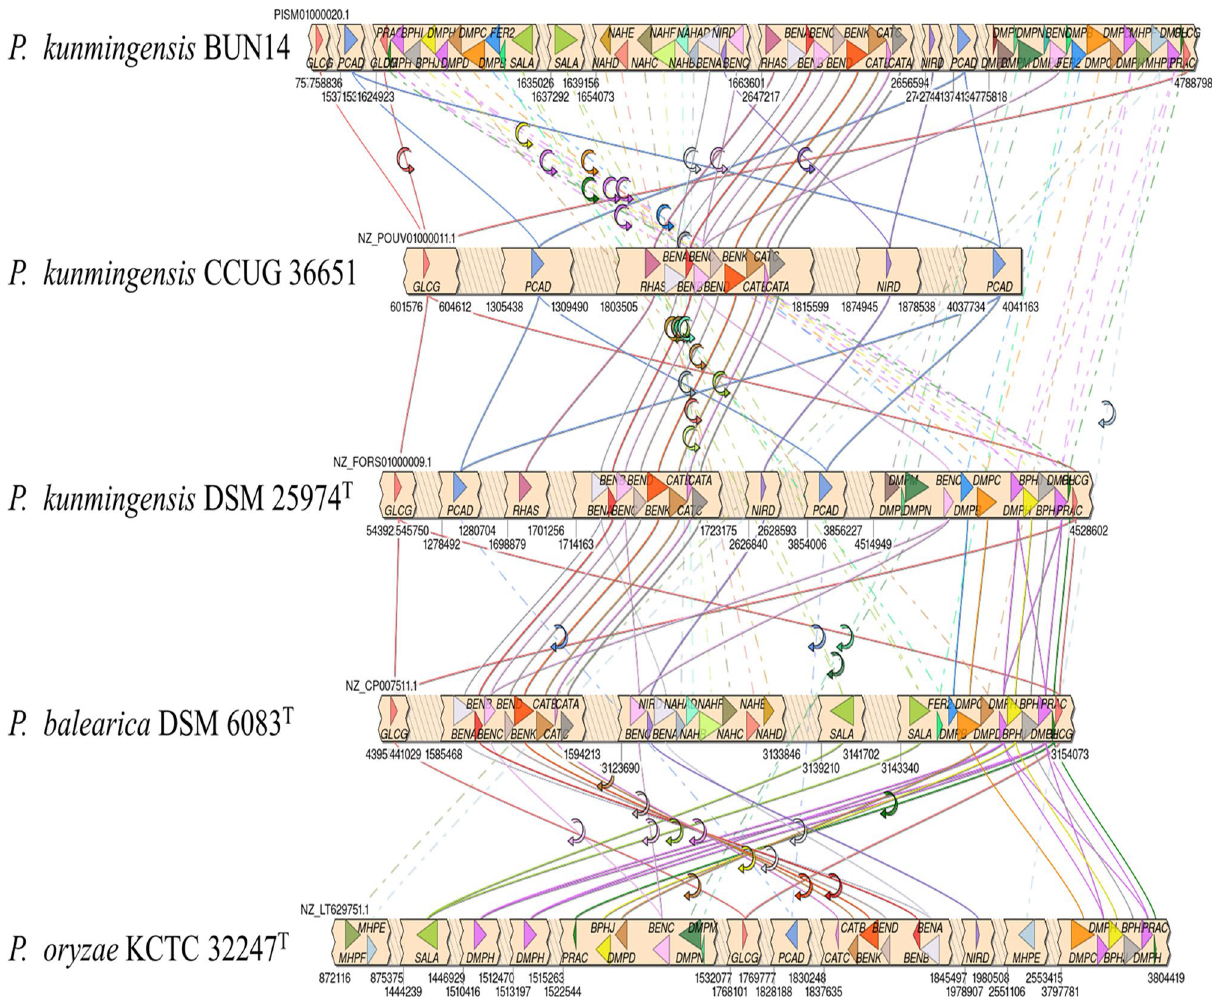
Figure 6. Synteny map showing the genomic locations of genes linked to benzoate, dioxin and naphthalene degradation pathways for strain BUN14 and related species. The map was generated with SimpleSynteny server version 1.4 (https:// dvelt ri. com/ simpl esynt eny/ advan ced.